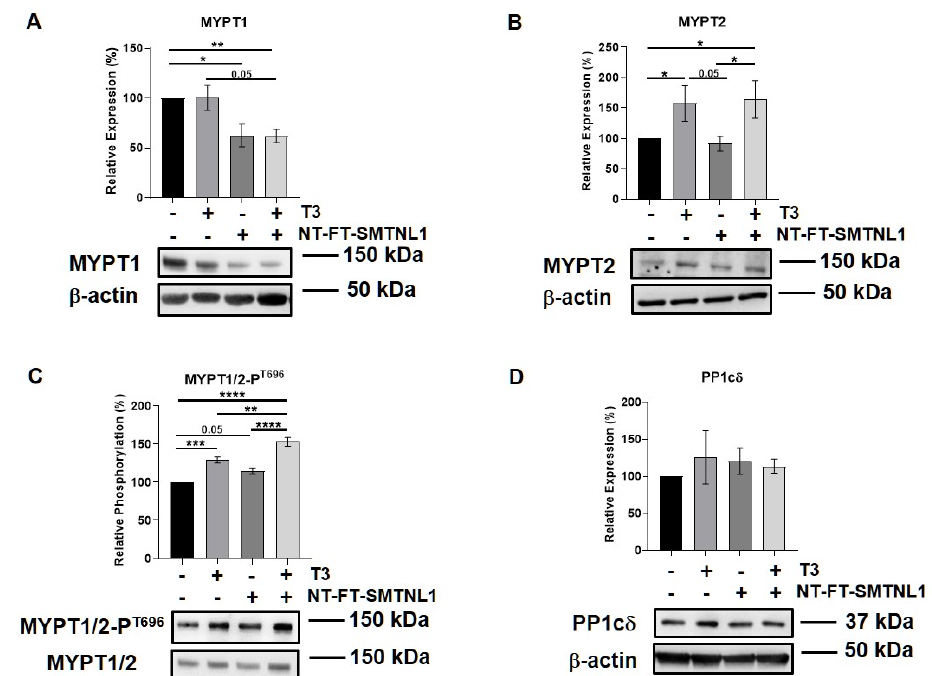
Figure 6. T 3 Treatment and SMTNL1 overexpression influence the expression and phosphorylation of myosin phosphatase target subunits in myotubes. Myoblasts were transfected with empty vector or NT-FT-SMTNL1 and were differentiated with a simultaneous 72-h T 3 treatment started from Day 4. Whole-cell lysates were analyzed using Western blot with anti-MYPT1 ( A ), anti-MYPT2 ( B ), anti- MYPT1/2-P T696 ( C ) and anti-PP1c δ ( D ). Values represent n = 3, mean ± SEM. Data were normalized to the empty vector-transfected control. Differences between group means were determined using One-way ANOVA and Tukey’s post hoc test, p < 0.05 (*), p < 0.01 (**), p < 0.001 (***), p < 0.0001 (****).